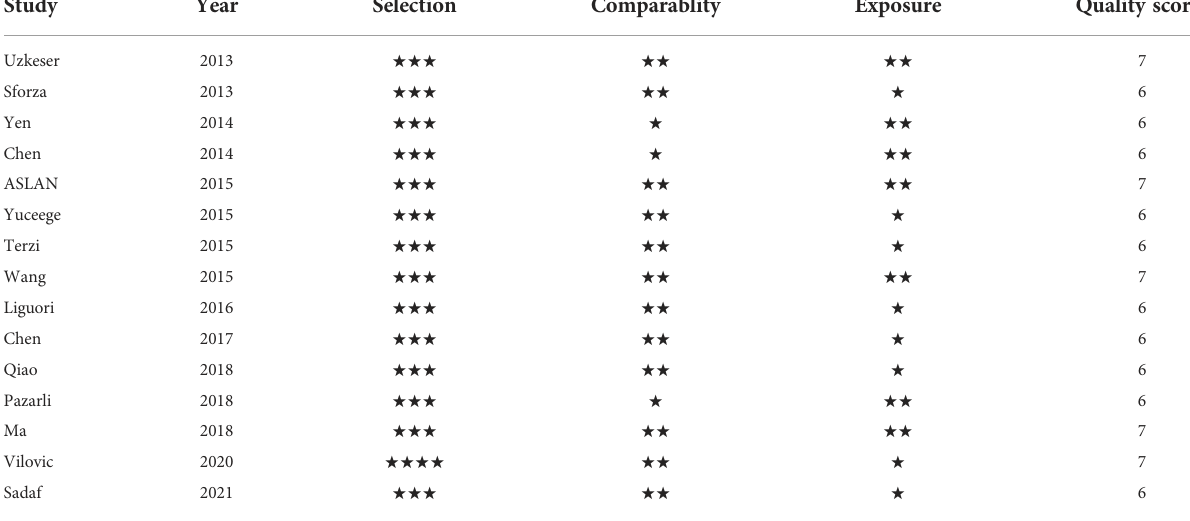
TABLE 2 Newcastle – Ottawa Scale of the included studies.